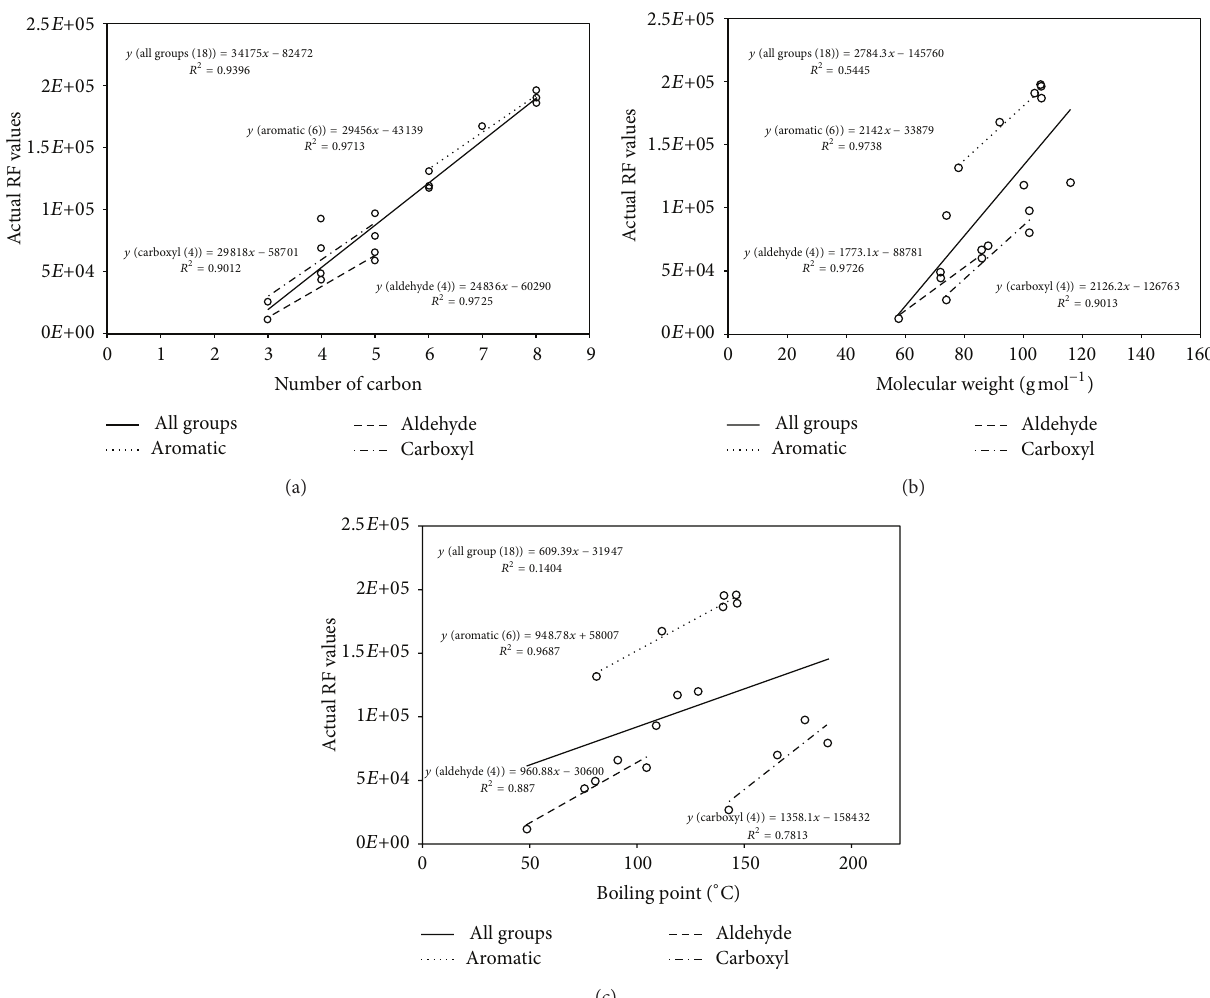
Figure 1: The correlations between RF values and key variables: (a) carbon number, (b) molecular weight, and (c) boiling point in Exp-TD.